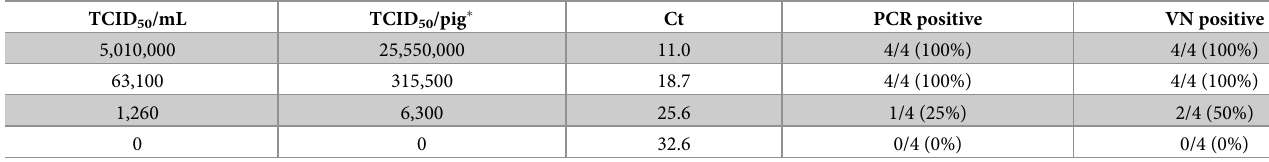
Table 5. Summary of SVA infection outcomes in finishing pigs by PCR and VN assays.